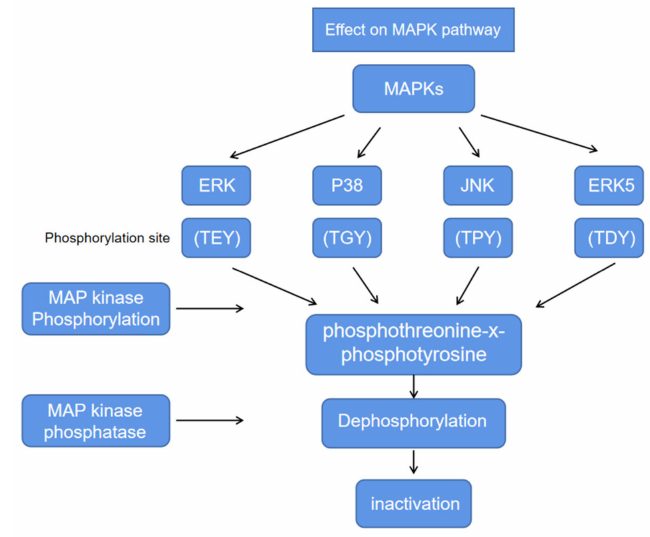
Figure 2. Effect on Mitogen-activated protein kinases pathway.